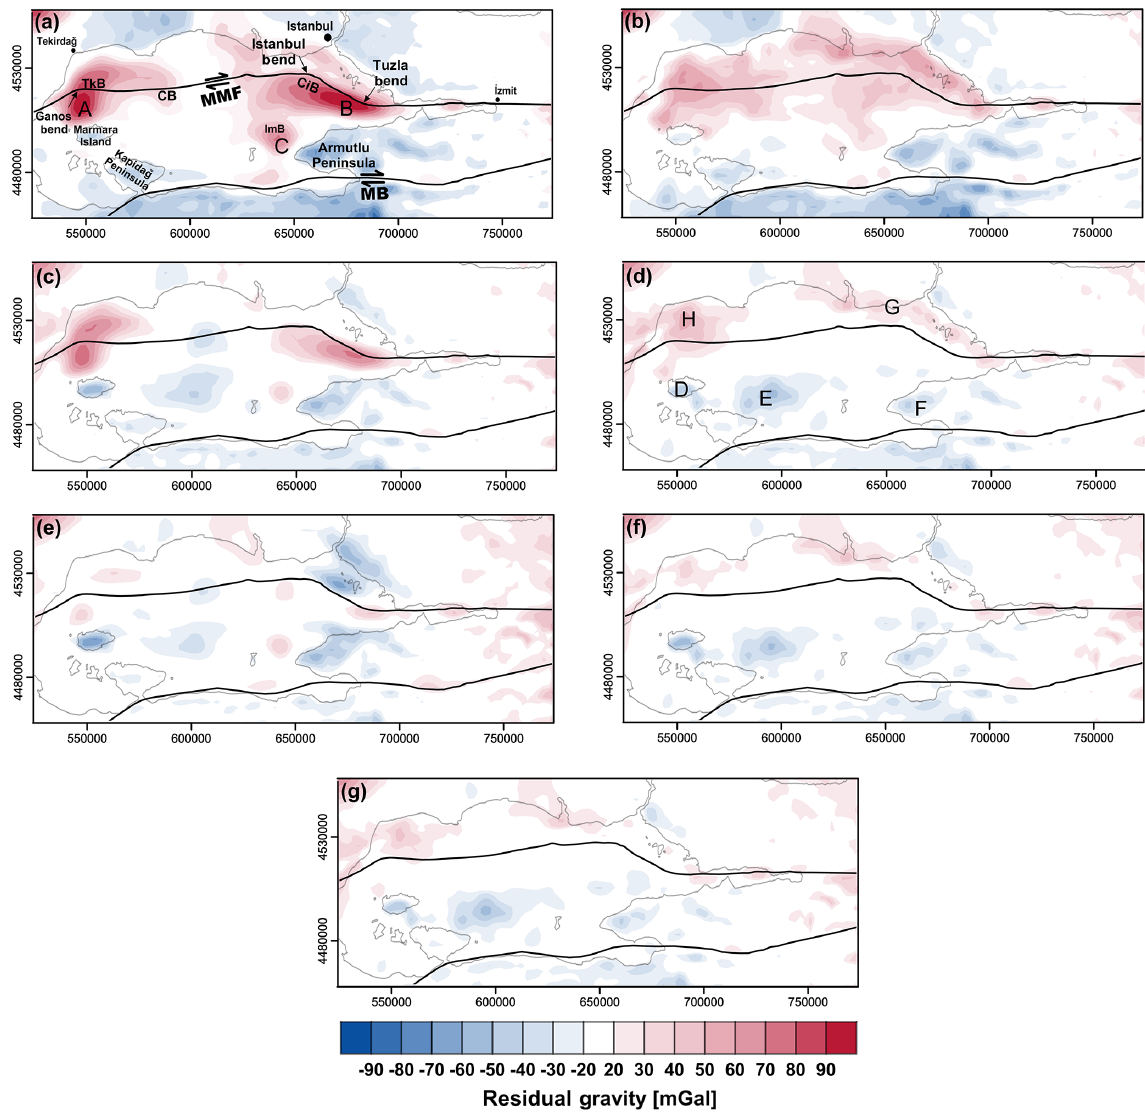
Figure 8. Residual gravity anomaly maps show the misfit between the observed (Fig. 5) and calculated gravity (Fig. 7) of different structural models across the study area (WGS84, UTM zone 35 ◦ N). (a) Initial model to EIGEN-6C4 (Förste et al., 2014). (b) Initial model to Improved- TOPEX (Kende et al., 2017). (c) Model with a differentiated crustal unit to EIGEN-6C4. (d) Model with a differentiated crustal unit to Improved-TOPEX. (e) Model I, the best-fit model based on the forward gravity modeling in EIGEN-6C4. (f) Model II, the best-fit model based on the forward gravity modeling on Improved-TOPEX. (g) Model III, the alternative best-fit model based on the forward gravity modeling in Improved-TOPEX. The average density for the modeled high-density bodies is 3150kgm − 3 in Model I and Model II and 2890kgm − 3 in Model